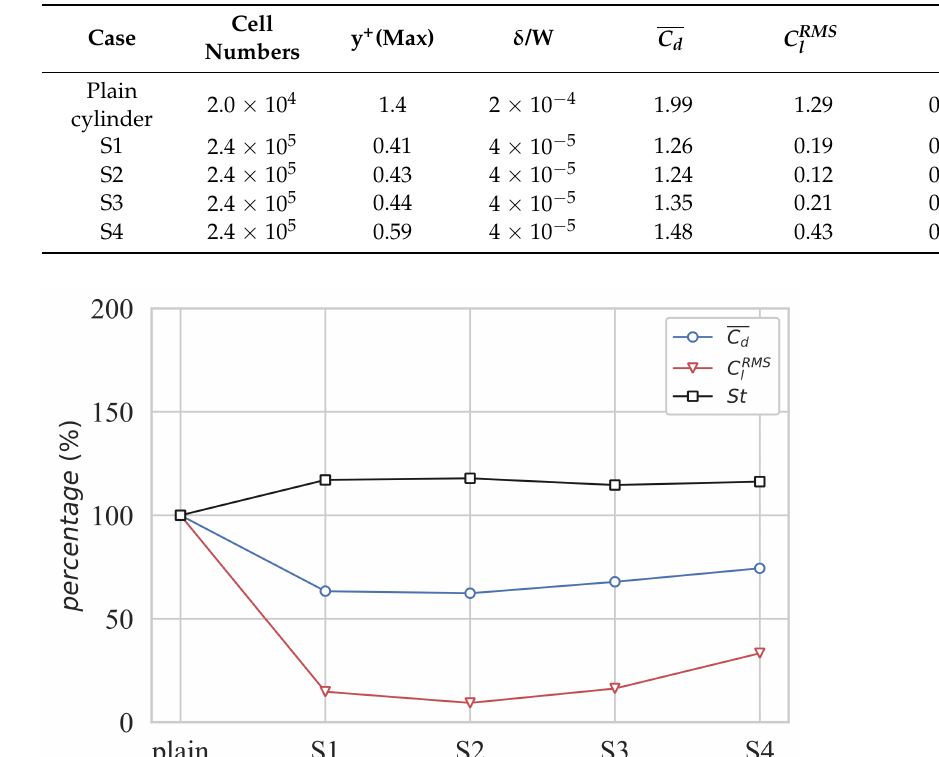
Table 5. Force coefficient for four stationary cases and plain cylinder.